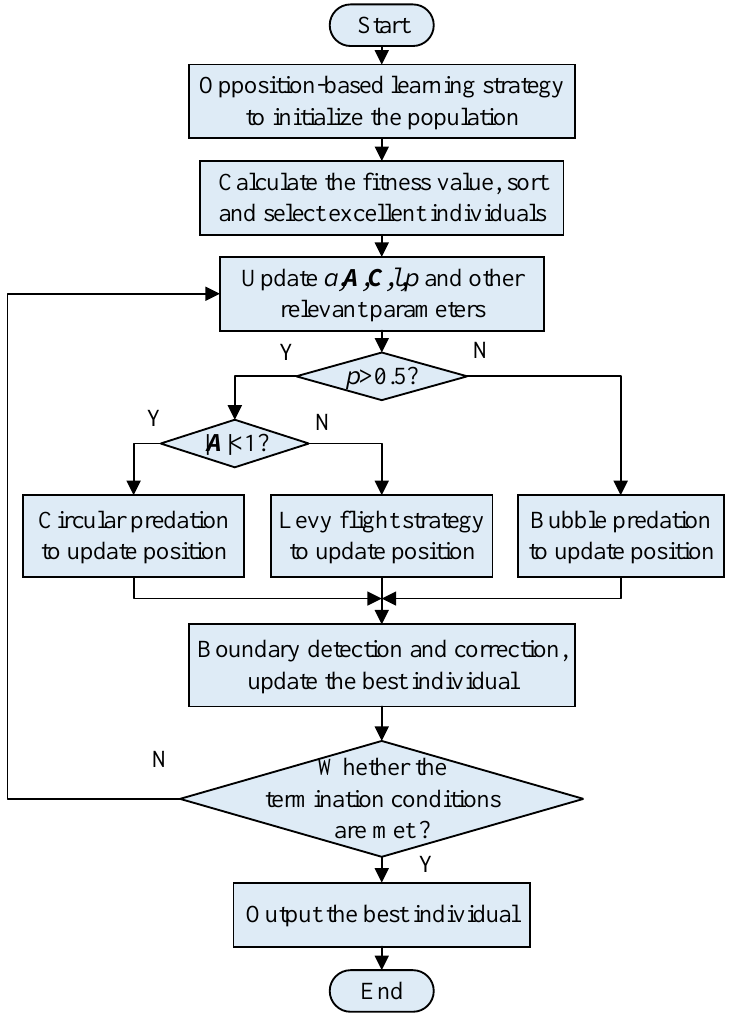
Figure 5. Flow chart of improved whale optimization